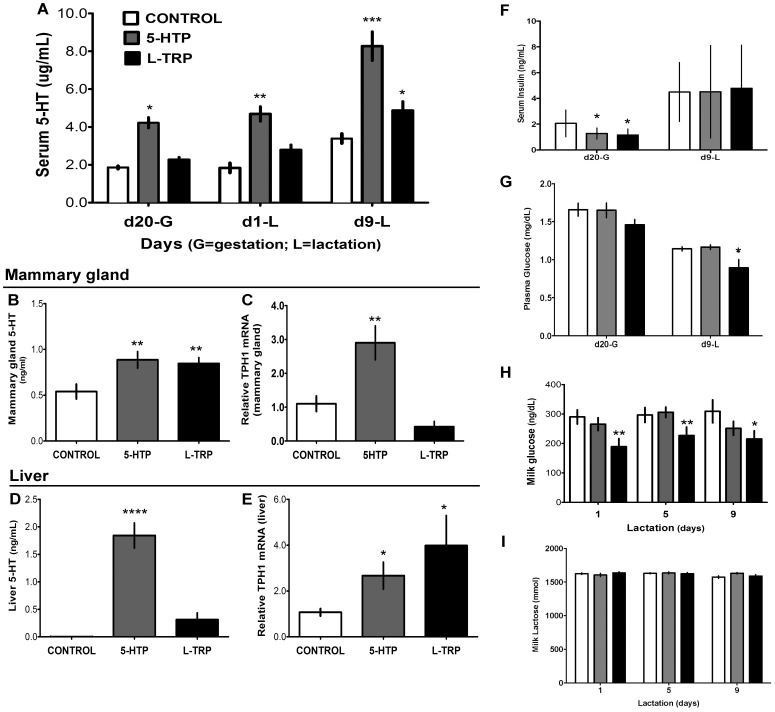
Effects of feeding diets enriched in 5-HTP and L-TRP on serum 5-HT, insulin and glucose in rats.Serum 5-HT concentrations on d20 of gestation (d20-G), d1 and d9 of lactation (d1-L, d9-L) (A). 5-HT protein concentration and mRNA expression of TPH1 in the mammary gland (B-D) and liver (E-G) on d9-L. Serum insulin (H) and plasma glucose (I) concentrations on d20-G and d9-L, milk glucose concentrations at d1, d5 and d9 of lactation (J), in dams fed CON, 5-HTP, and L-TRP diets, and milk lactose concentrations at d1, d5, and d9 of lactation (I), in dams fed CON, 5-HTP, and L-TRP diets. Data are represented as mean ± SEM. Single asterisk (*) indicate statistical significance at P<0.05, two asterisks (**) at P<0.01, three (***) at P<0.001 and four (****) at P<0.0001.